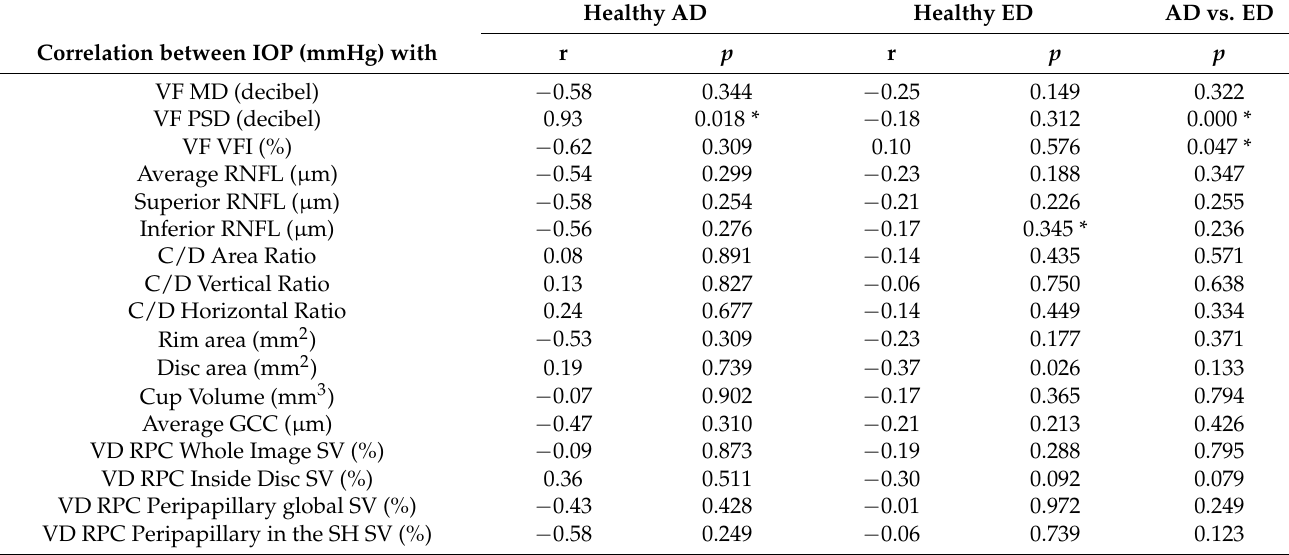
Table 5. Spearman correlations (r) between intraocular pressure (IOP) and functional, structural